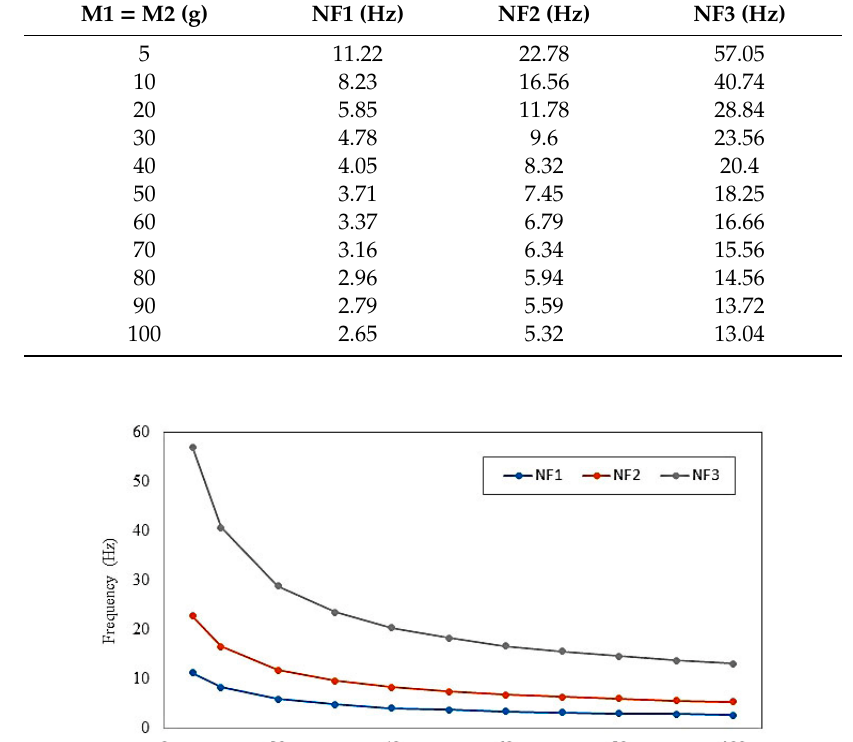
Table 4. First three resonant peaks for various masses obtained by ANSYS (NF: natural frequency).